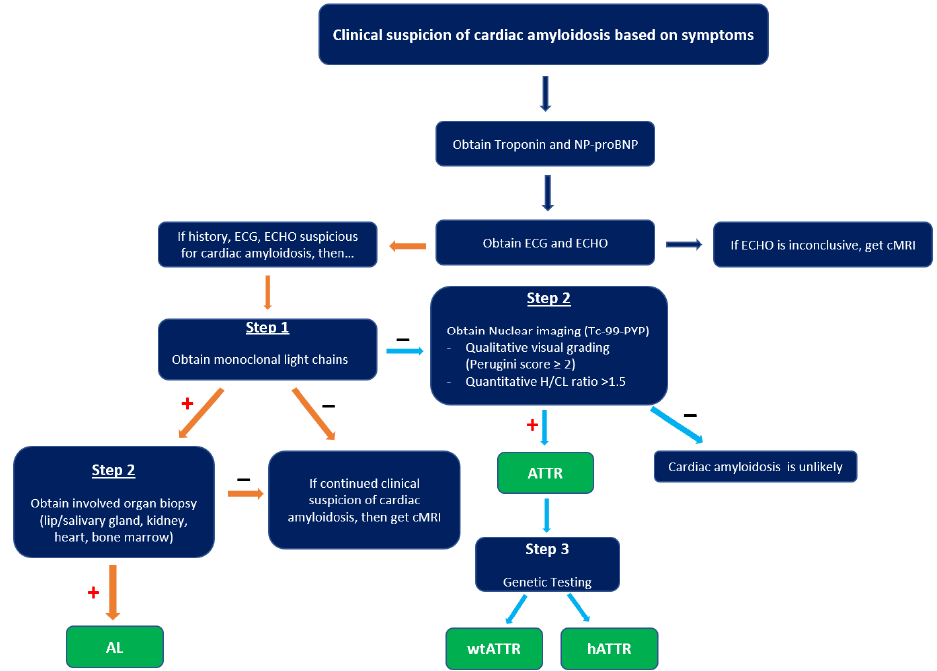
Figure 7. Diagnostic algorithm of cardiac amyloidosis. cMRI, cardiac magnetic resonance imaging; H/CL, heart-to-contralateral lung ratio; AL, amyloid light chain; wtATTR, transthyretin amyloid wild type; hATTR, transthyretin amyloid hereditary. “+” indicates criteria met in prior box, while “–“ indicates criteria not met in prior box.